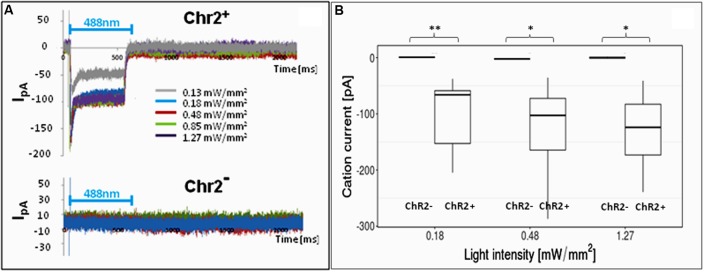
Electrophysiological responses to illumination. In response to illumination ChR2-expressing RGl cells displayed inward cation current [I in picoampers (pA)] depending on the laser intensity. ChR2-non-expressing cells did not respond with ion currents to light stimulation. (A) A Representative series of recordings from ChR2+ (upper graph) and ChR2- RGl cells. (B) distribution of peak ion currents in response to illumination with different light intensities (n = 4 for ChR2-, and n = 7 for ChR2+ cells).